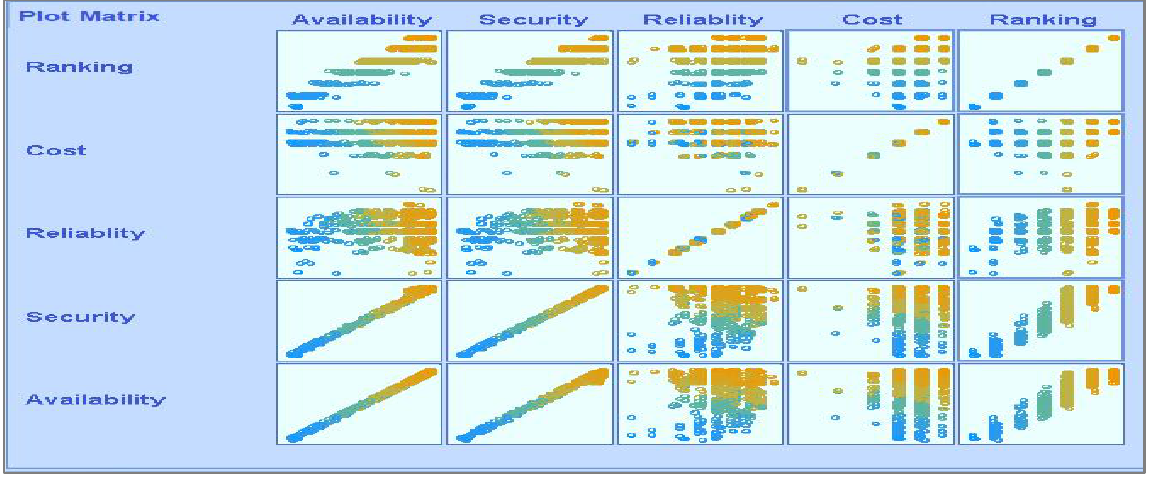
Figure 8. Parametric distribution of dataset.